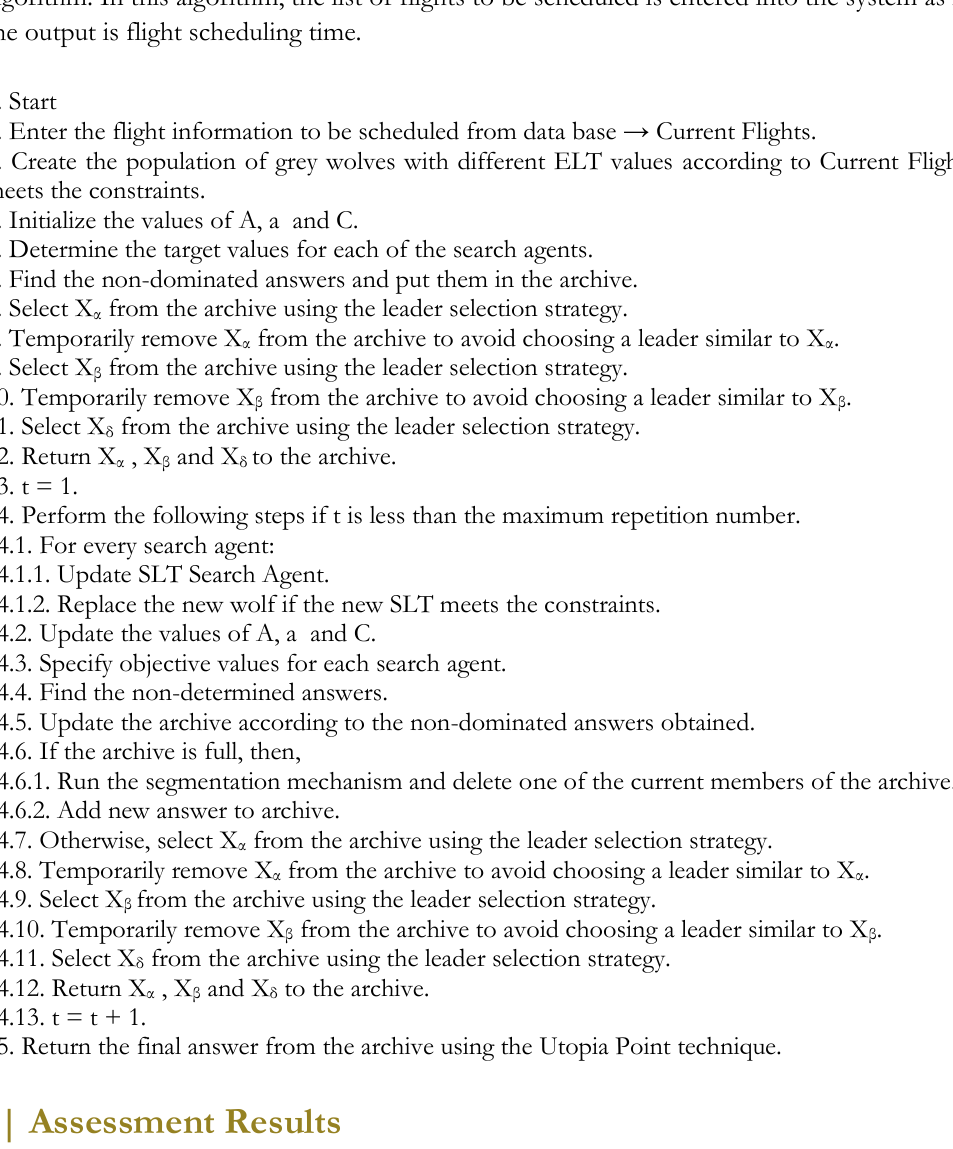
Fig. 1. Determination of the optimal point and the best answer from the archive.